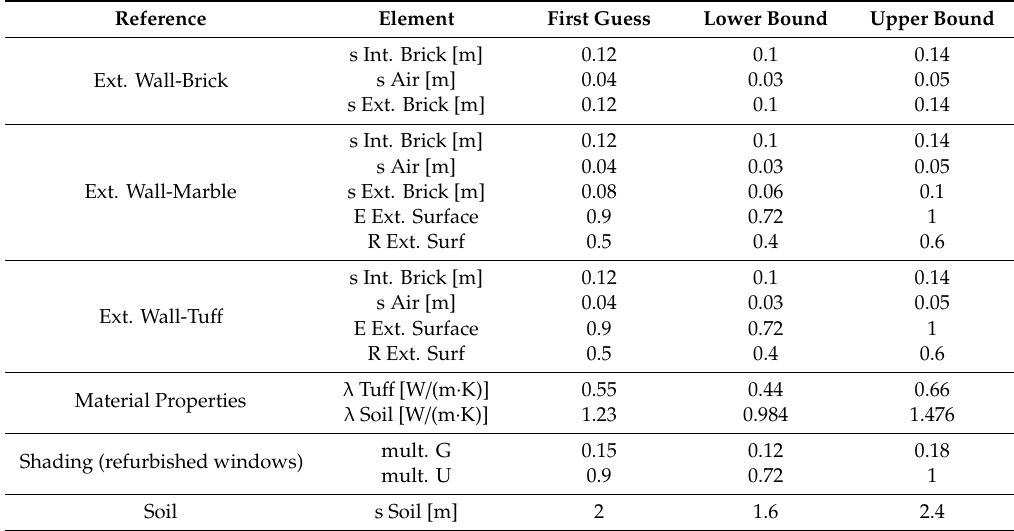
Table 10. Parameters collection for Sensitivity Analysis B